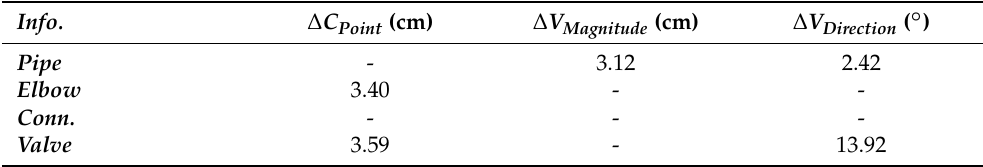
Table 6. IUA metrics on T MAP test